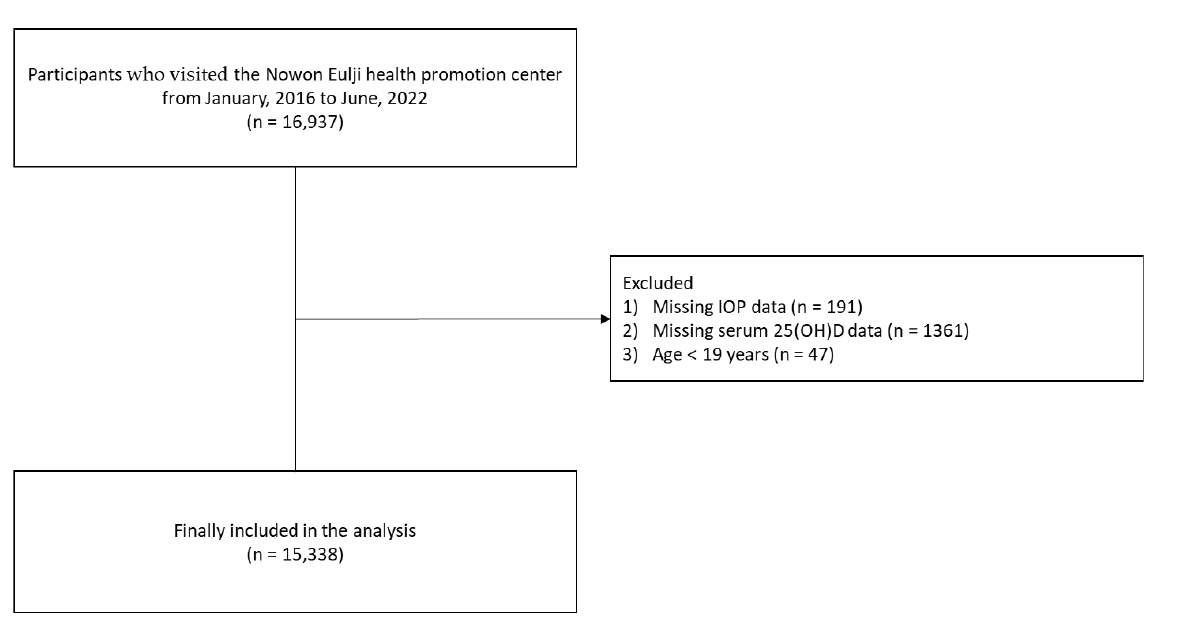
Figure 1. Flowchart of the study population selection. Abbreviations: intraocular pressure, intraocular pressure; 25(OH)D, 25-hydroxyvitamin D.